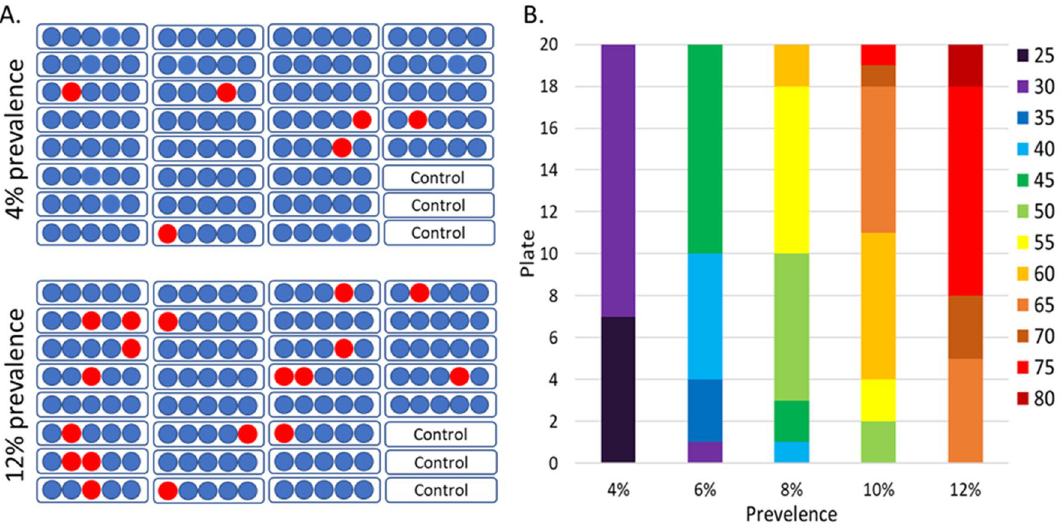
Figure 5. Effect of prevalence rate on the number of samples that require repeat testing. ( A ) Visual display of the first predicted plates for 4% and 12% prevalence in the testing population. The 12% prevalence illustrates the increased likelihood of multiple positives being pooled randomly into the same well. ( B ) 20 plates were predicted for each prevalence level using random number generation to examine the effect of prevalence on the number of samples that required reanalysis. The colors indicate the number of samples that require rerun of samples independently to identify the positive sample based on 5-sample pools.